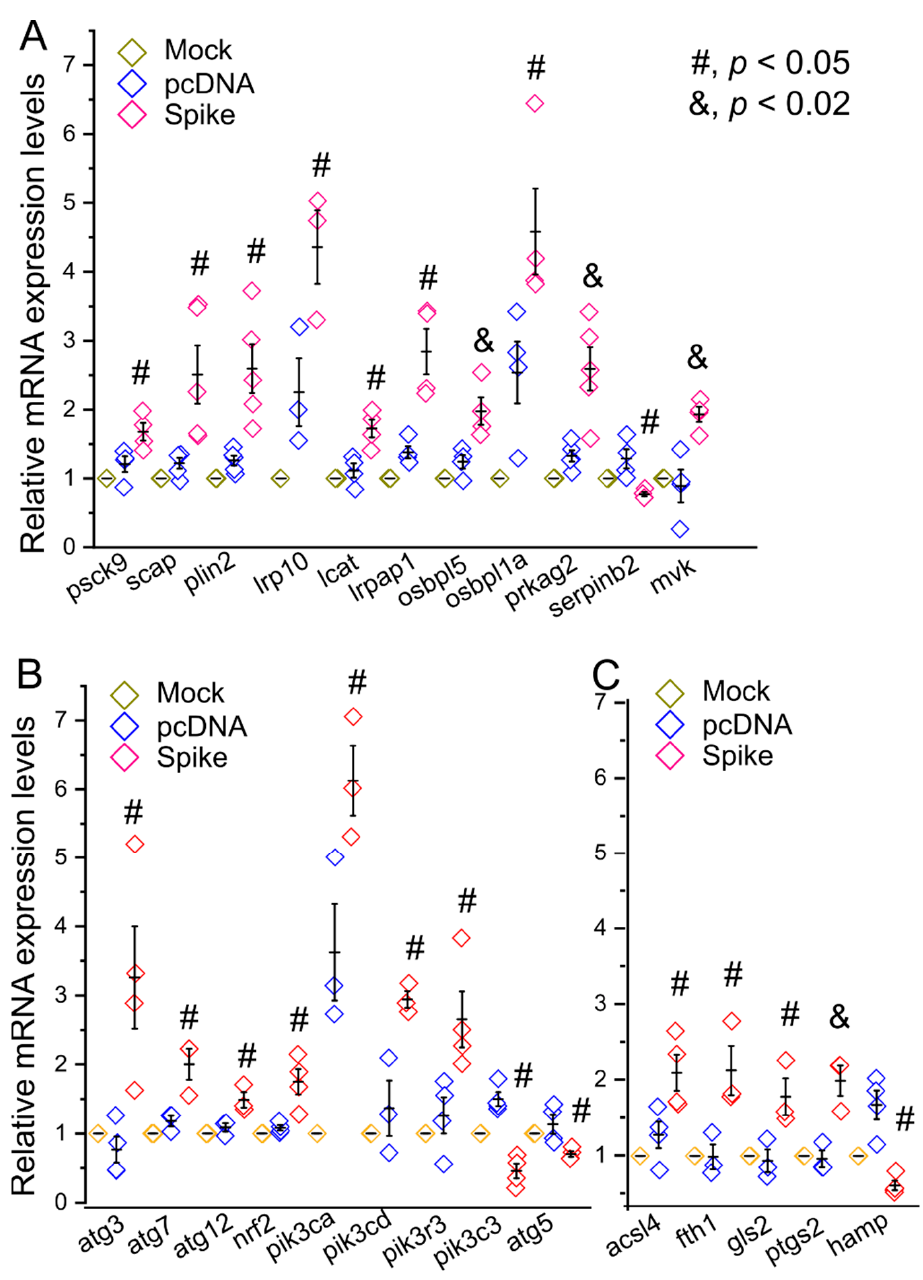
Figure 2. Transcriptional profiles of representative biomarkers for lipid metabolism, autophagy, and ferroptosis. Relative mRNA levels of biomarkers involving lipid metabolism ( A ), autophagy ( B ), and ferroptosis ( C ) in the mock, pcDNA, and Spike cells. The normalization was performed using a converted index of β -actin, nono, and GAPDH as the reference genes.